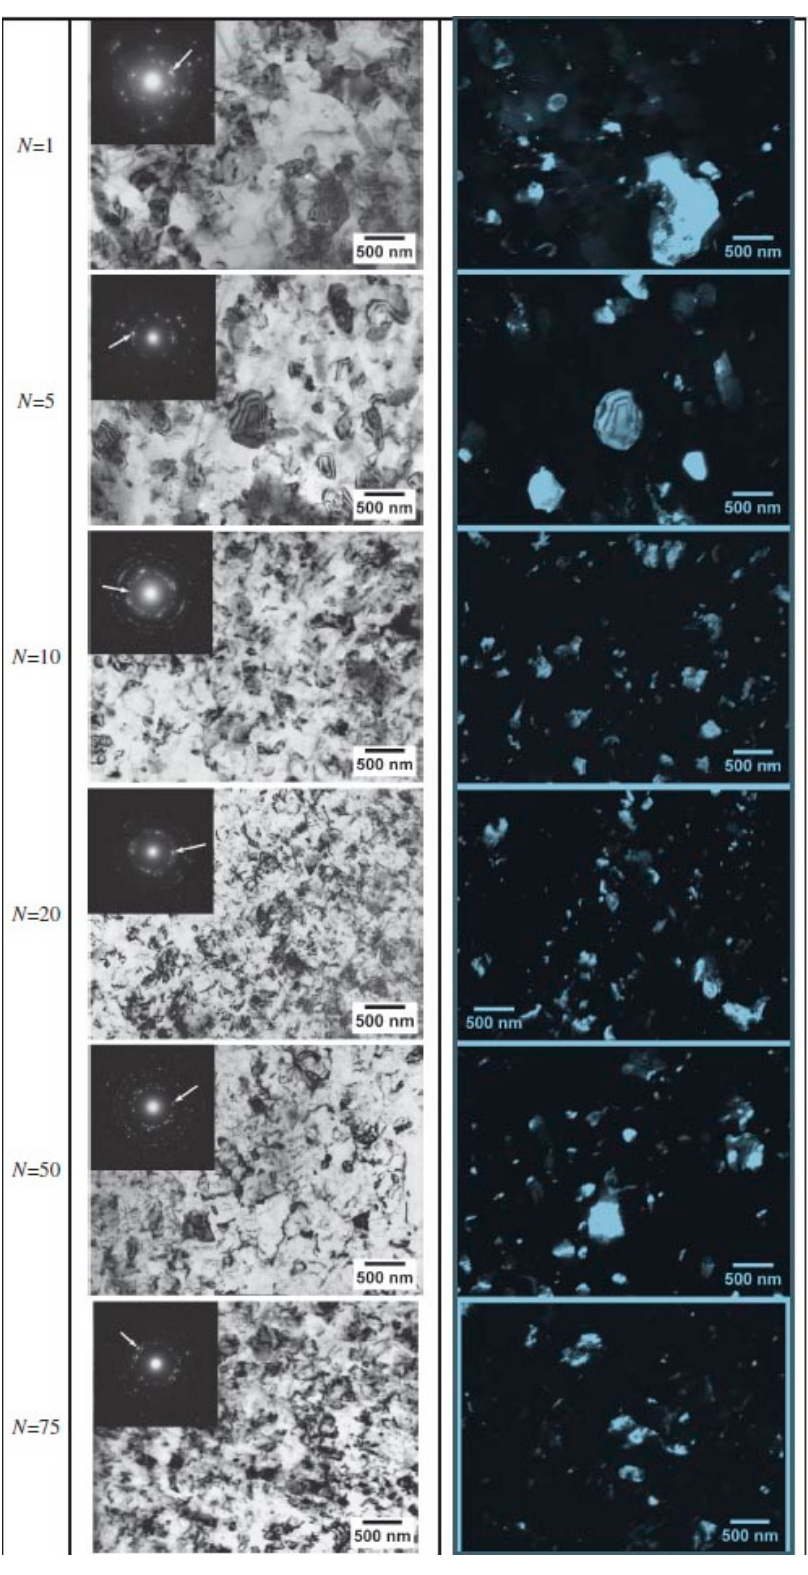
Figure 11. TEM micrographs showing Al—4% Fe EXT + HPT microstructure evolution for different number of anvil rotations n . Dark field images obtained from diffracted beams indicated by arrows in corresponding SAED patterns (as insets in bright field images). Reprinted with permission from ref. [90]. Copyright 2012 Elsevier.